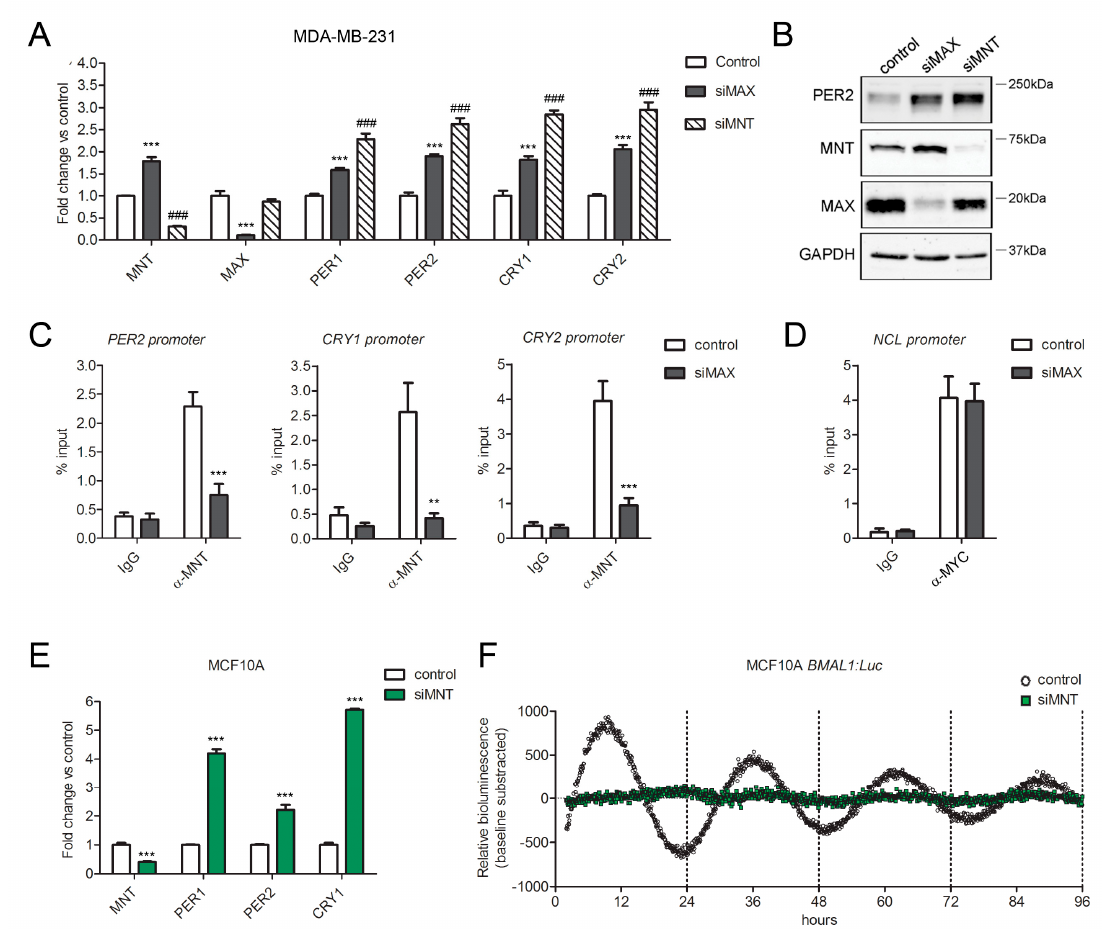
Figure 7. MAX repression of clock genes requires MNT. ( A ) Expression of clock genes PER1 , PER2 , CRY1 and CRY2 in MDA-MB-231 cells upon the knockdown of MAX (siMAX), MNT (siMNT). Relative expression was determined by qRT–PCR using GAPDH for normalization. Values of control cells were set to 1. Shown as mean + SEM, n ≥ 3. *** p < 0.001 and ### p < 0.001, two-way ANOVA with Bonferroni post hoc test, siMAX or siMNT versus control cells, respectively. ( B ) Protein levels of PER2, MNT and MAX in MDA-MB-231 cells transfected with siRNA sequences against MAX (siMAX), MNT (siMNT) or a non-targeting control. GAPDH was used as a loading control. ( C ) Recruitment of MNT on the promoters of PER2, CRY1 and CRY2 in MAX-silenced (siMAX) and control MDA-MB-231 cells. Enrichment of MNT was evaluated by quantitative PCR of immunoprecipitated DNA compared with input DNA (% of input). Immunoglobulin G (IgG) was used as a negative control. Shown as mean + SEM, n = 3. ** p < 0.01 and *** p < 0.001, two-way ANOVA with Bonferroni post hoc test, α -MNT precipitated DNA from siMAX versus control chromatin samples. ( D ) Chromatin samples from C (MAX-silenced and control) were immunoprecipitated with α -MYC. Enrichment of MYC on the MYC-target NCL promoter was evaluated by quantitative PCR of immunoprecipitated DNA compared with input DNA (% of input). Immunoglobulin G (IgG) was used as a negative control. Shown as mean + SEM, n = 3. ( E ) Expression of clock genes PER1 , PER2 , CRY1 in MCF10A cells knocked down for MNT (siMNT). Relative expression was determined by qRT–PCR using GAPDH for normalization. Values of control cells were set to 1. Shown as mean + SEM, n ≥ 3. * p < 0.05, ** p < 0.01 and *** p < 0.01, two-way ANOVA with Bonferroni post hoc test, silenced versus control cells. ( F ) Real-time bioluminescence oscillatory pattern in MNT -silenced (siMNT, green dots) and control (black dots) MCF10A cells expressing a firefly luciferase reporter controlled by the circadian-responsive BMAL1 promoter. Shown as baseline-subtracted luminescence data fitted to a sine